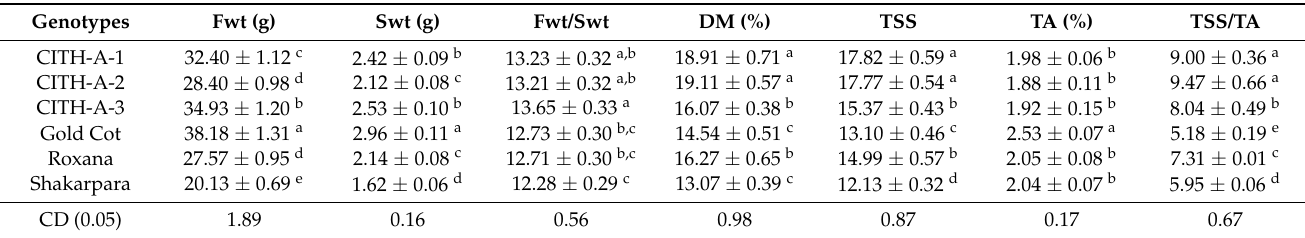
Table 1. Variation in physicochemical composition of apricot